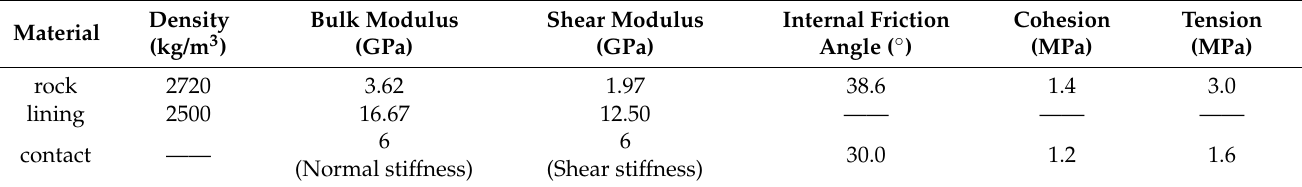
Table 1. Parameters of